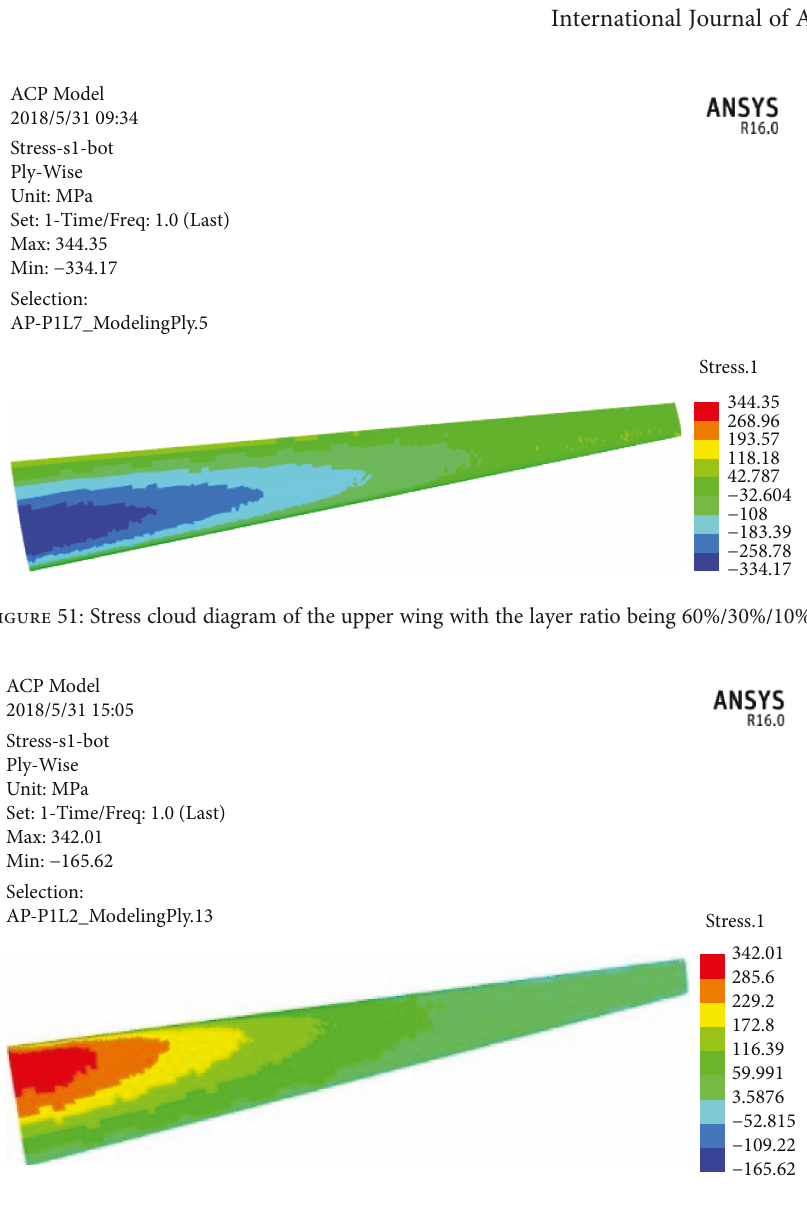
Figure 52: Stress cloud diagram of the lower wing with the layer ratio being 60%/30%/10%.